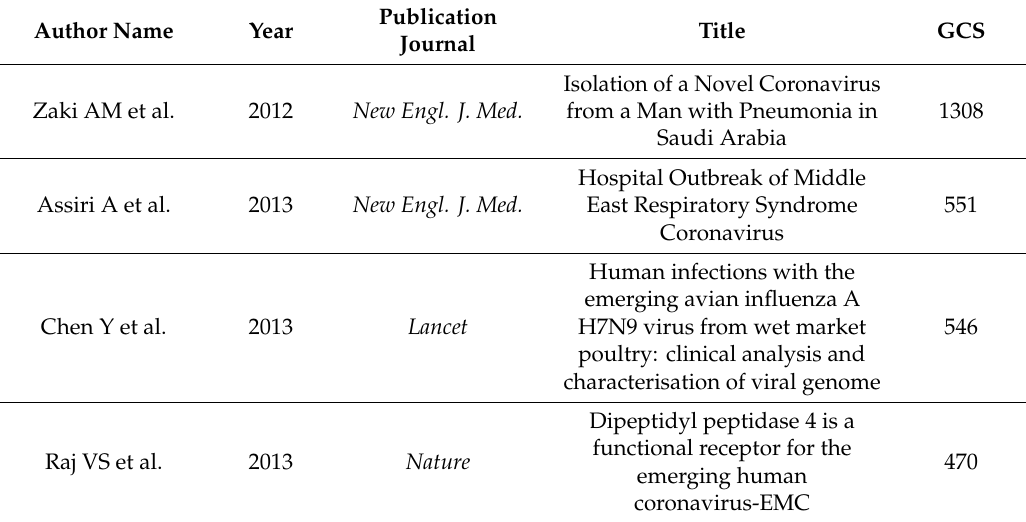
Table 8. Top cited papers with over 400 citations during